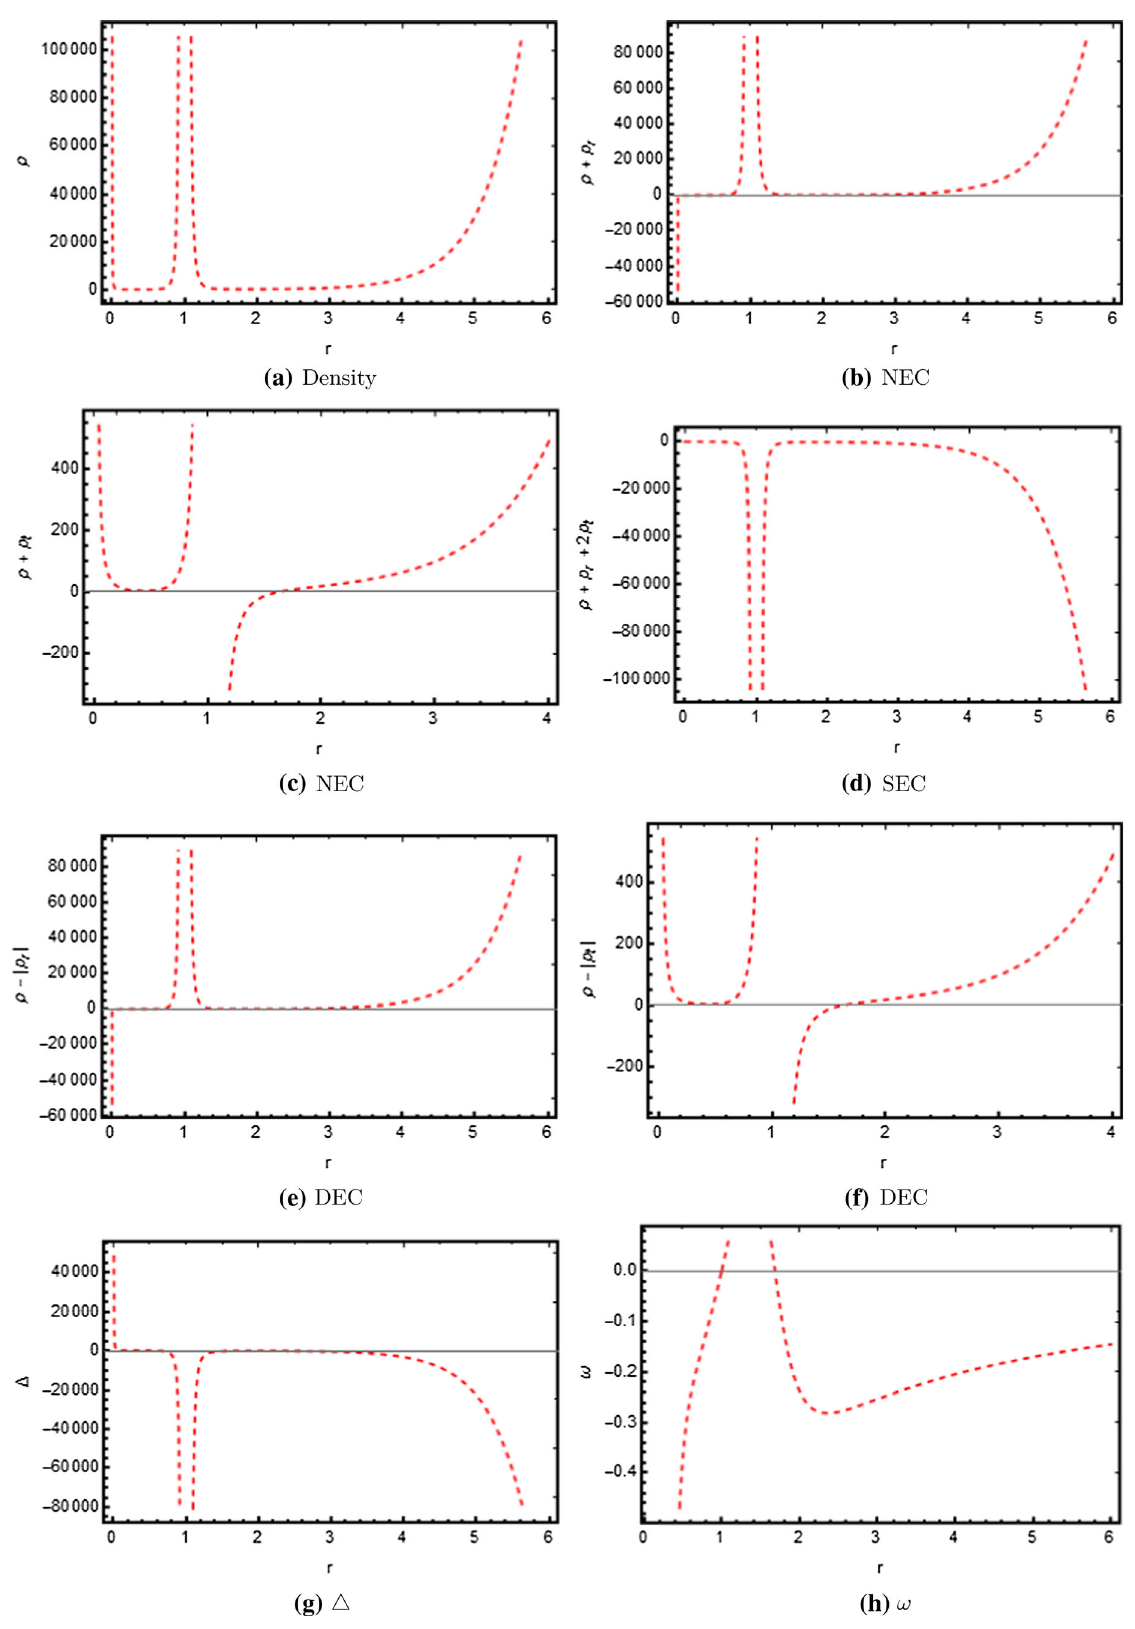
Fig. 1 Plots for Density, NEC, SEC, DEC, (cid:11) & ω using φ( r ) = constant with n = − 1 and α >